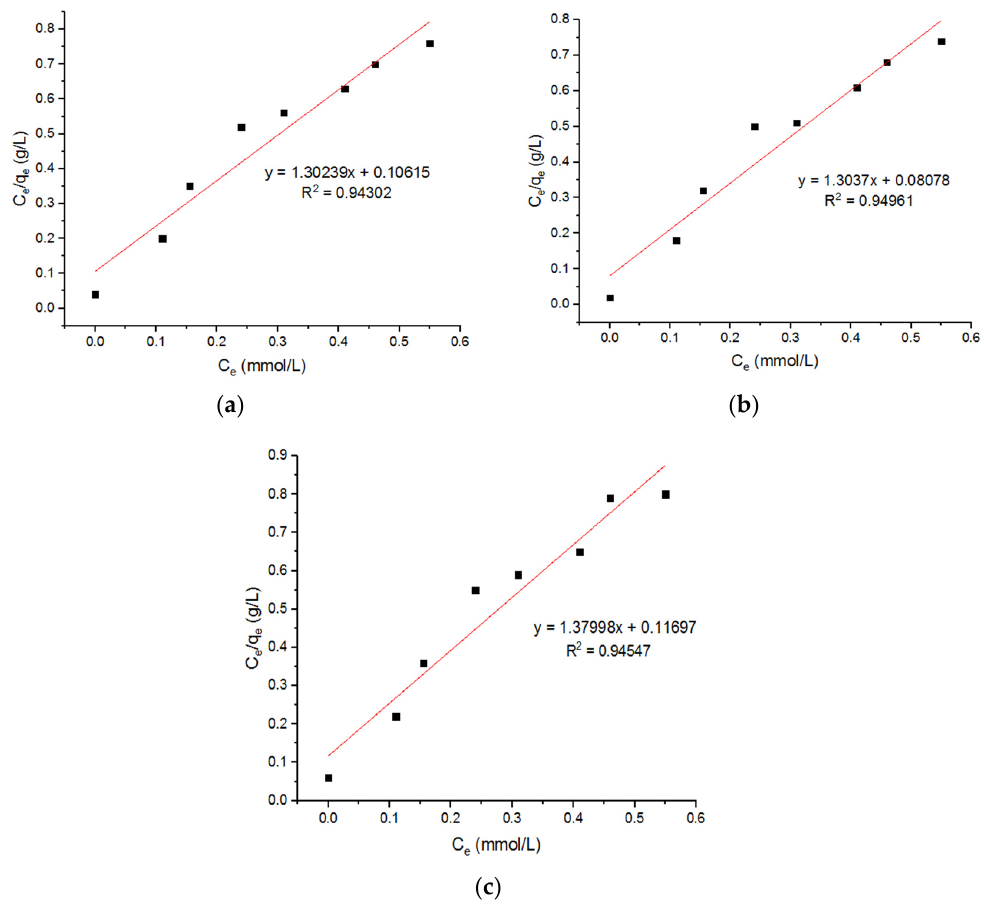
Figure 17. Langmuir plots for adsorption of Zn 2+ ions onto MgFe 2 O 4 -NH 2 nanoparticles pre-functionalization-calcined at ( a ) 500 °C, ( b ) 600 °C, and ( c ) 700 °C. Table 6. Isotherm parameters calculated from Langmuir